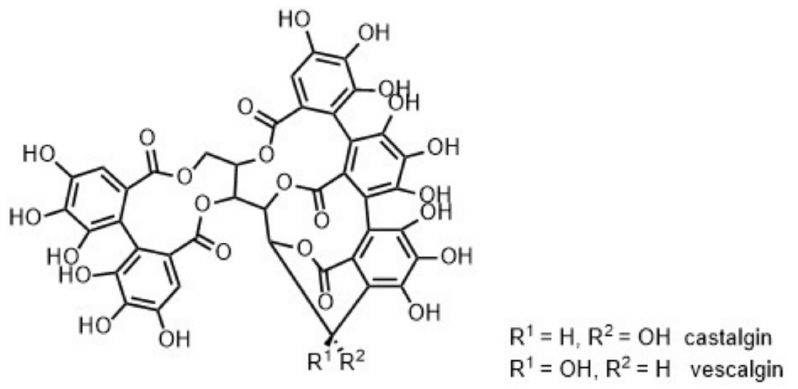
Figure 8. Structural representation delineated on the basis of NMR and MALDI-ToF data of VEGE- TAN CN POLVERE ( Cs